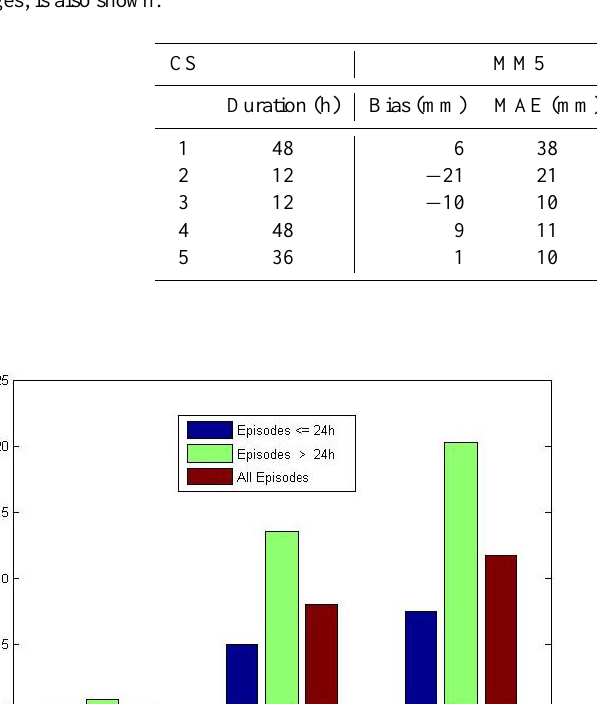
Table 3. Verification indices (Bias, MAE and O/P) corresponding to MM5’s and COSMO-I7’s QPF performances for the five case studies analysed in this study. The ratio O/P, corresponding to the total summed observed rainfall depth over its predicted value for all XEMA rain gauges, is also shown.